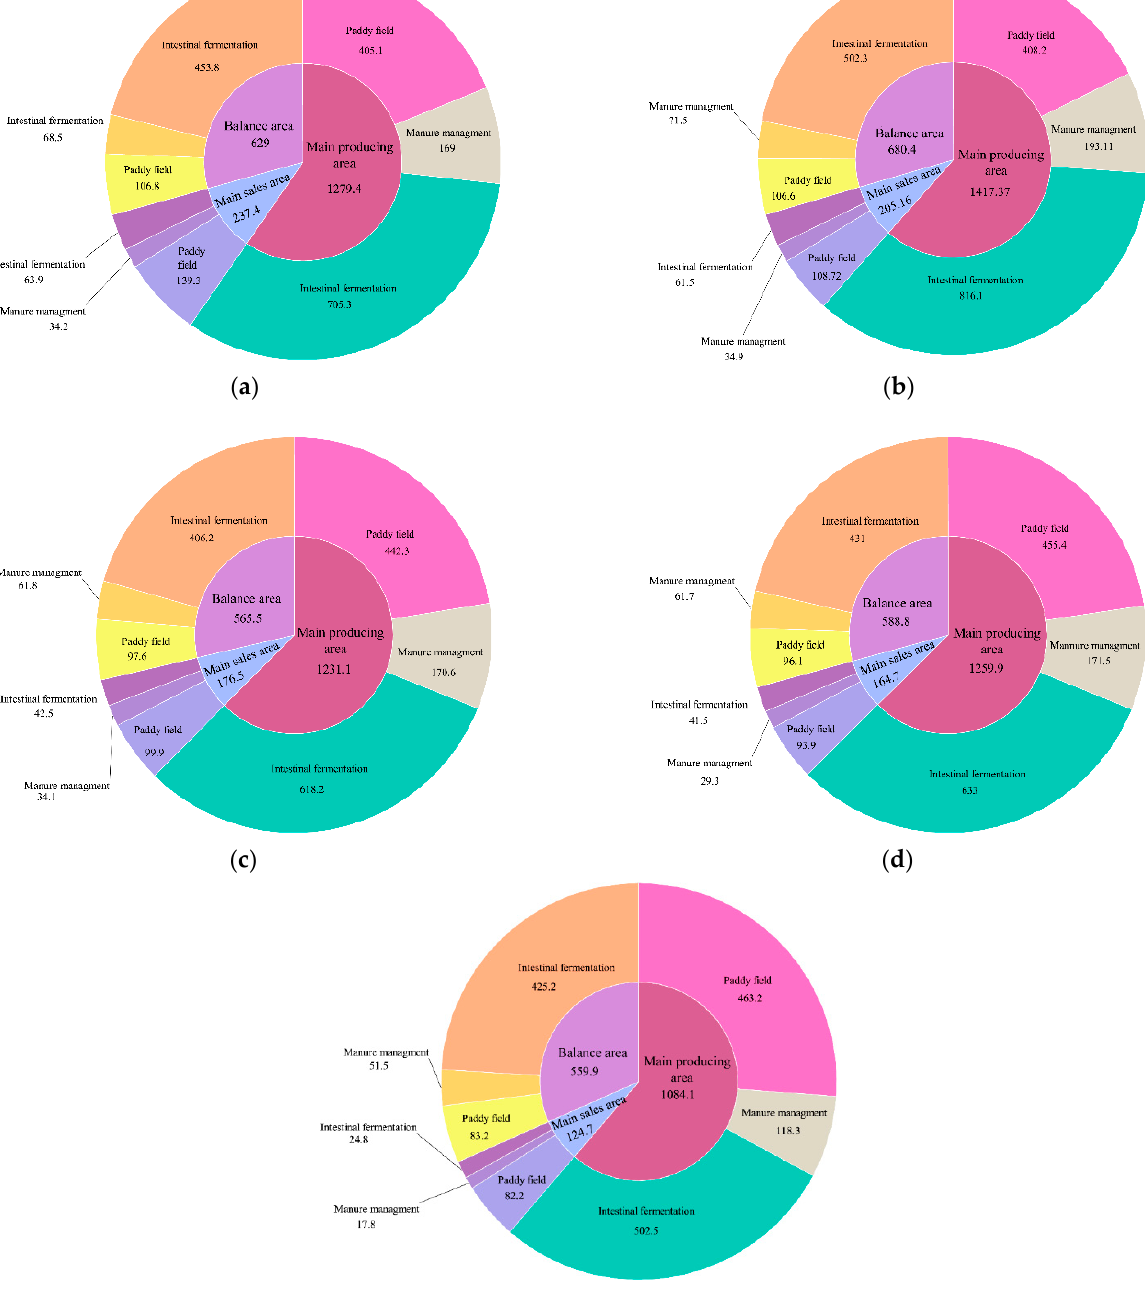
Figure 3. Agricultural methane emissions by region in China, 2000–2019. ( a ) 2000; ( b ) 2005; ( c ) 2010; ( d ) 2015; and ( e ) 2019.